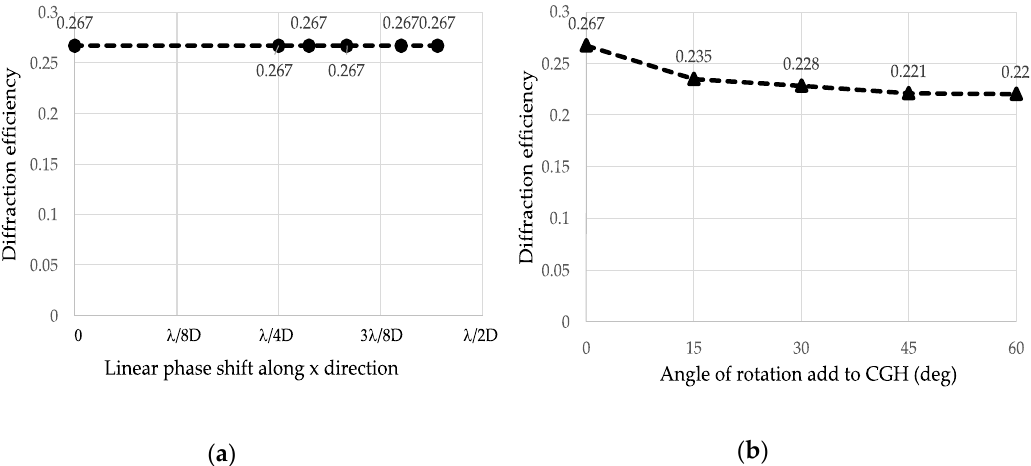
Figure 10. ( a ) Diffraction efficiency of a CGH for single-point beam steering of period number r = 2 with horizontal shift, and ( b ) DE for single-point beam steering of period number 2 with rotation.